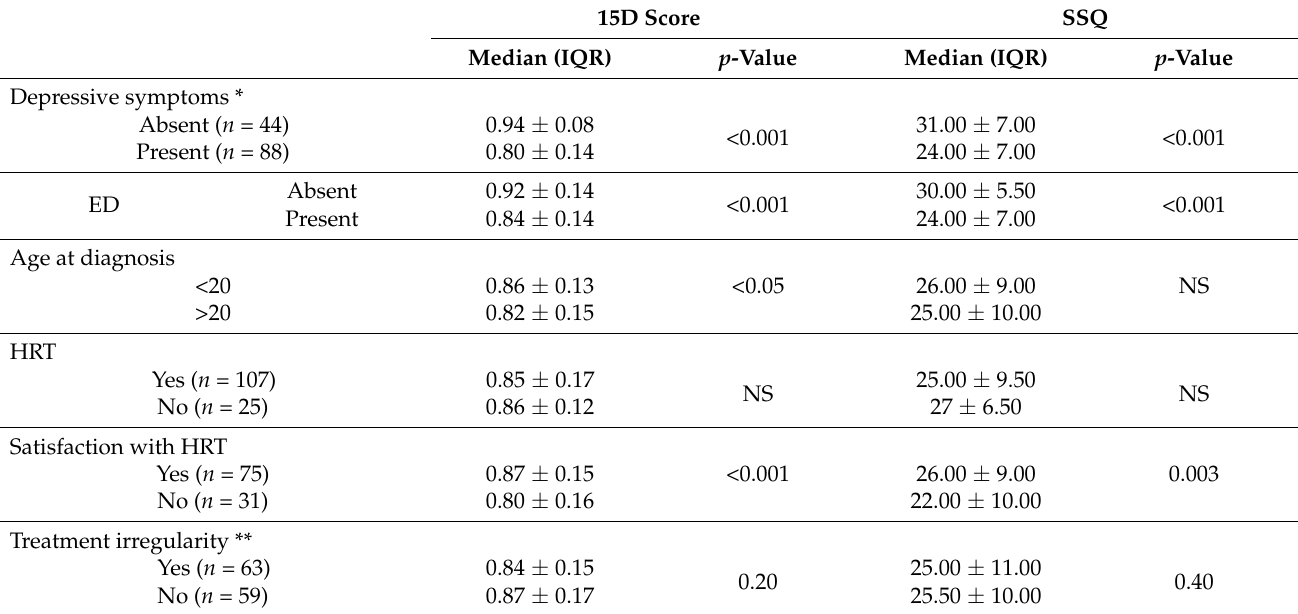
Table 4. Comparison between IHH patient scores from 15D and SSQ in relation to SDS index scores, IIEF-5 scores, age at diagnosis, HRT received, treatment satisfaction and